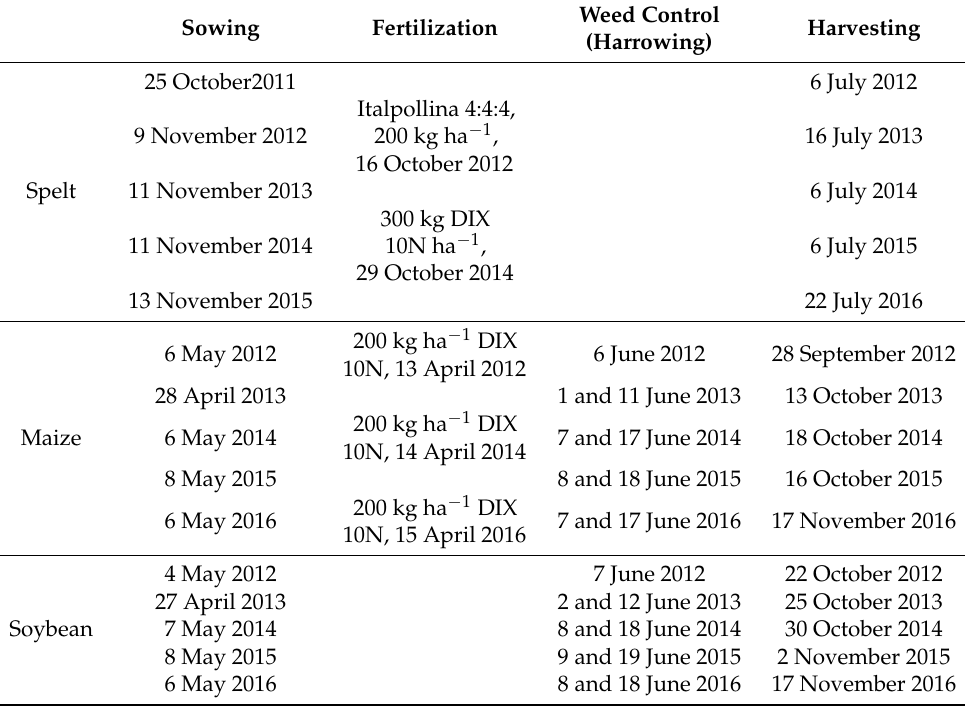
Table 1. Calendar of main cropping practices in experiment during 2011–2016 period.